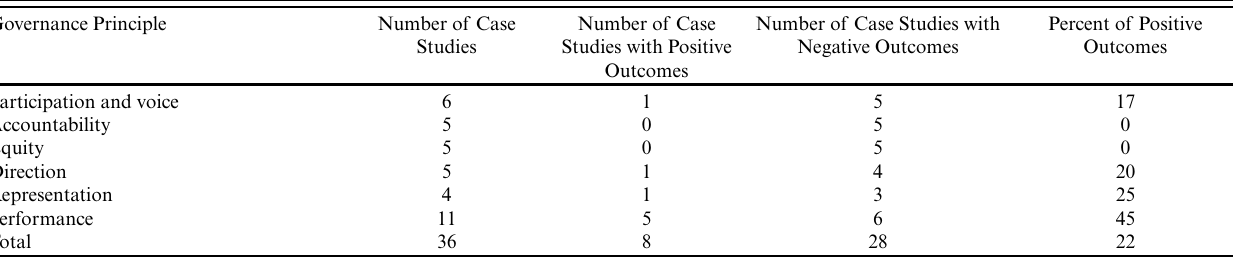
Table 9 . Summary of community forest governance outcomes from this